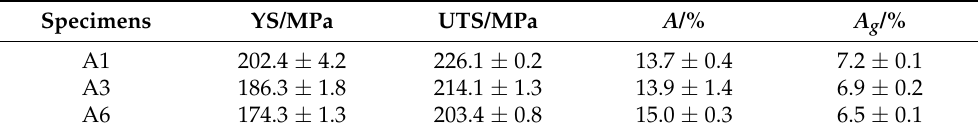
Table 4. Mechanical properties of three